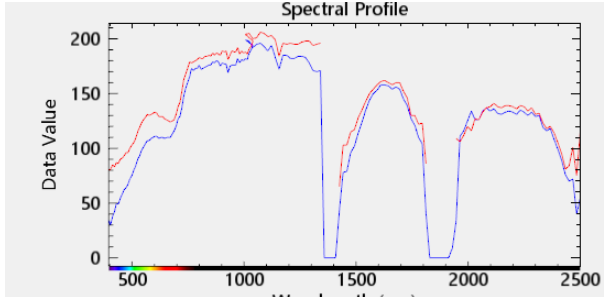
Figure 7 . Spectral curve comparison of ZY1-02D buildings